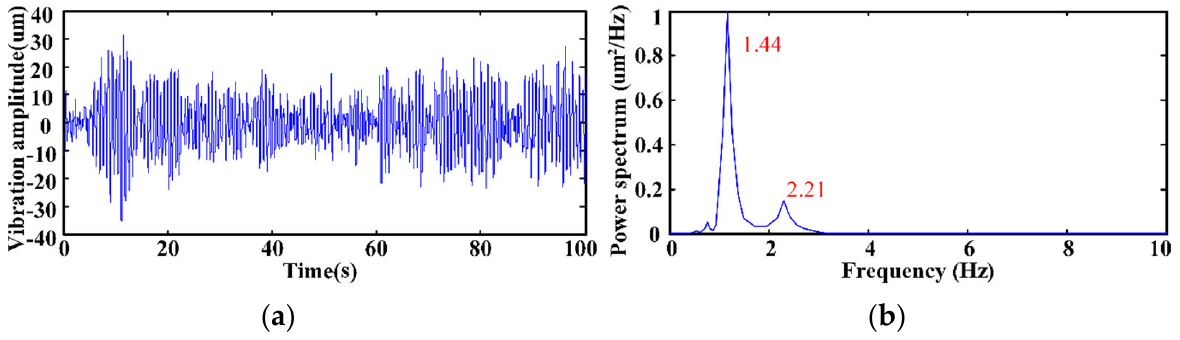
Figure 5. Time history signals and power spectra of B3 measuring point under condition 2. ( a ) Time history signals; ( b ) Normalized power spectra.